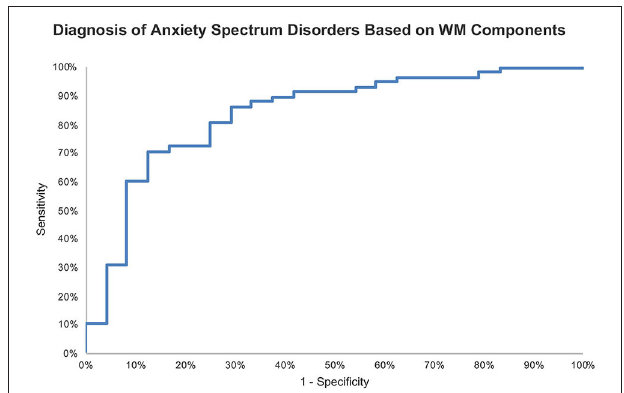
FIGURE 4 | ROC curve of probabilities generated by logistic regression for identifying anxiety spectrum disorders based on WM components with AUC =